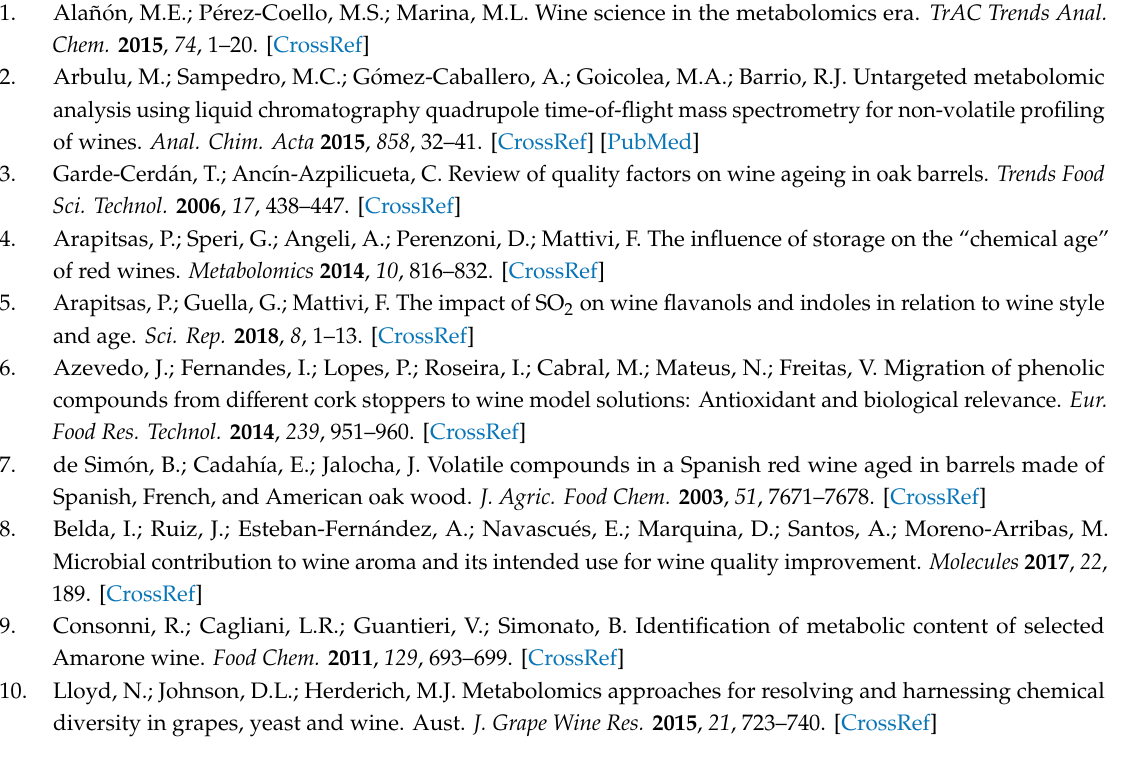
Figure S2: Log2 values of NMR metabolites with practical significance for the cellars FB (A,B) and ICVV (C–H). Figure S3: GC-MS targeted based on the factors barrel-type and time for cellar FB (A) and ICVV (C). Figure S4: PCoA for cellars FB (A) and ICVV (B) based on the LC-MS metabolites. Figure S5: LC-MS log2 values of metabolites for cellar FB. Acronyms BAO and BAN refer to barrel-aged wine from old and new barrels, respectively. Figure S6: LC-MS log2 values of metabolites for cellar ICVV. Figure S7: PCoA for cellars FB (A) and ICVV (B) based on the GC-MS metabolites. Figure S8: GC-MS log2 values of metabolites for cellar FB. Figure S9: GC-MS log2 values of first 25 out of 48 metabolites for cellar ICVV. Figure S10: GC-MS log2 values of last 23 out of 48 metabolites for cellar ICVV. Figure S11: NMR growth rates heatmap for periods 0–3, 3–6, 6–9, and 9–12 based on barrel-type (OLD or NEW) for cellar FB. Figure S12: NMR growth rates for period 0–12 of barrel-aged wine from new (BAN) and old (BAO) barrels as well as of bottle-aged wine from new (BTN) and old (BTO) barrels for cellar ICVV. Figure S13: NMR growth rates for periods 0–3, 3–9, and 9–12 based on barrel-type (OLD or NEW) for cellar ICVV. Values represent percentage of increase or decrease for each metabolite for the given period. Figure S14: LC-MS growth rates heatmap for periods 0–3, 3–6, 6–9, and 9–12 based on barrel-type (OLD or NEW) for cellar FB. Figure S15: LC-MS growth rates for period 0–12 of barrel-aged wine from new (BAN) and old (BAO) barrels as well as of bottle-aged wine from new (BTN) and old (BTO) barrels for cellar ICVV. Figure S16: LC-MS growth rates for periods 0–3, 3–9, and 9–12 based on barrel-type (OLD or NEW) for cellar ICVV. Figure S17: GC-MS growth rates heatmap for periods 0–3, 3–6, 6–9, and 9–12 based on barrel-type (OLD or NEW) for cellar FB. Figure S18: GC-MS growth rates for period 0–12 of barrel-aged wine from new (BAN) and old (BAO) barrels as well as of bottle-aged wine from new (BTN) and old (BTO) barrels for cellar ICVV. Figure S19: GC-MS growth rates for period 0–3, 3–9, and 9–12 based on barrel-type (OLD or NEW) for cellar